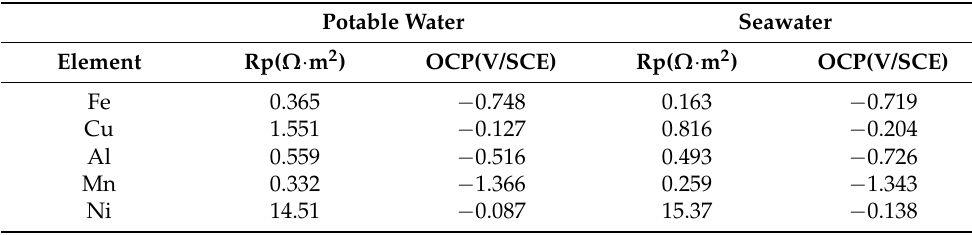
Table 5. Comparison of the pure metals’ corrosion properties.